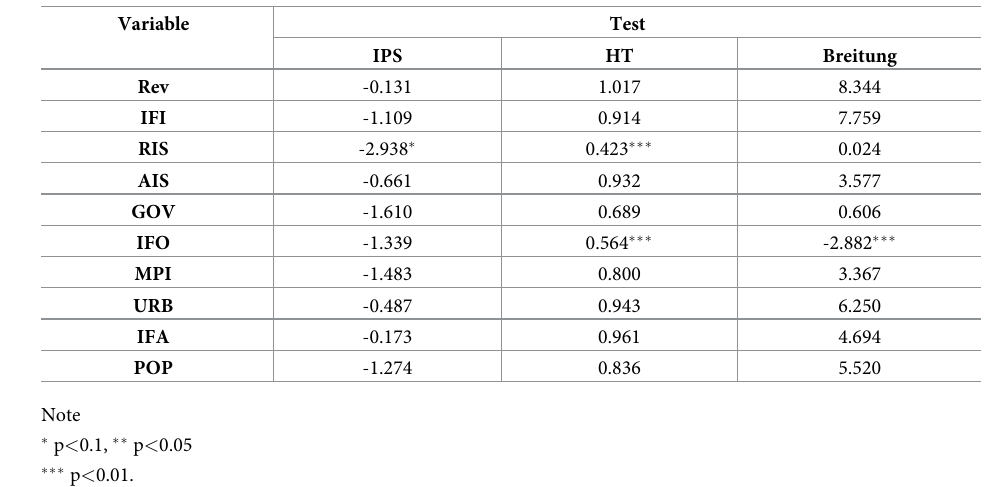
Table 5. Unit root